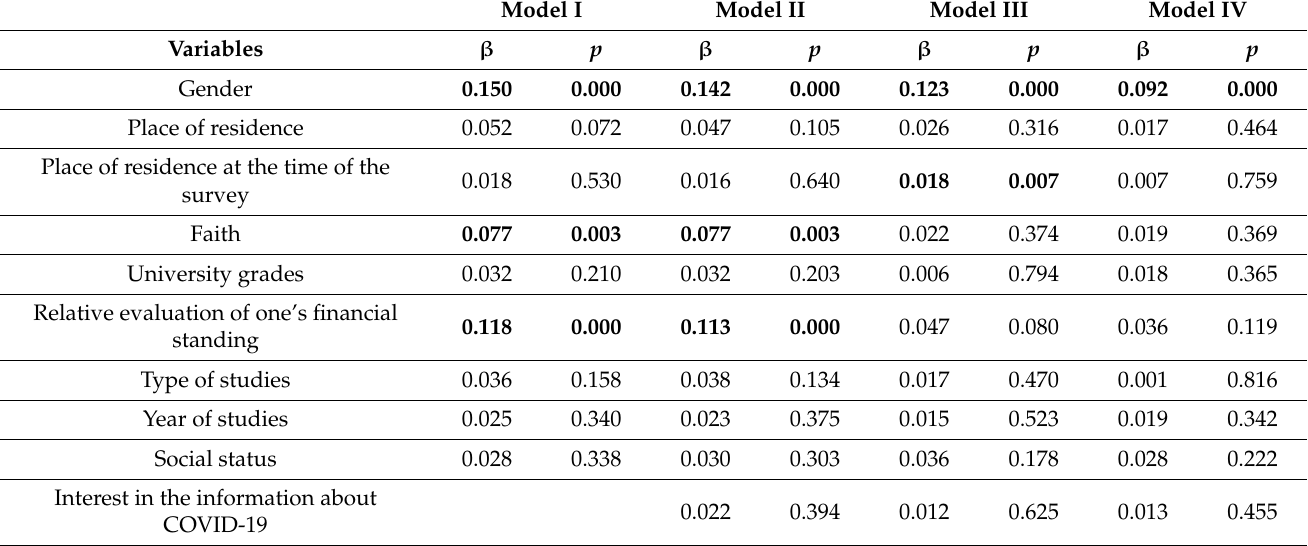
Table 2. Results of multiple regression analyses predicting the level of psychological